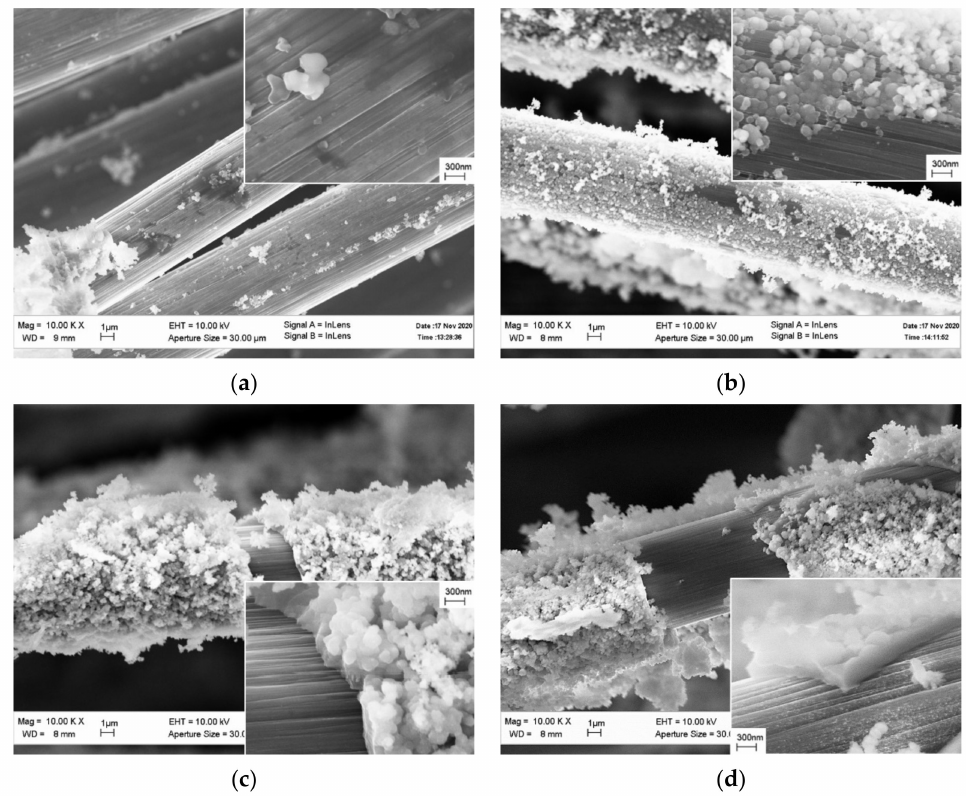
Figure 7. Surface of the coated carbon fiber formed in the reaction media with different molar ratios of TEOS to H 2 O: